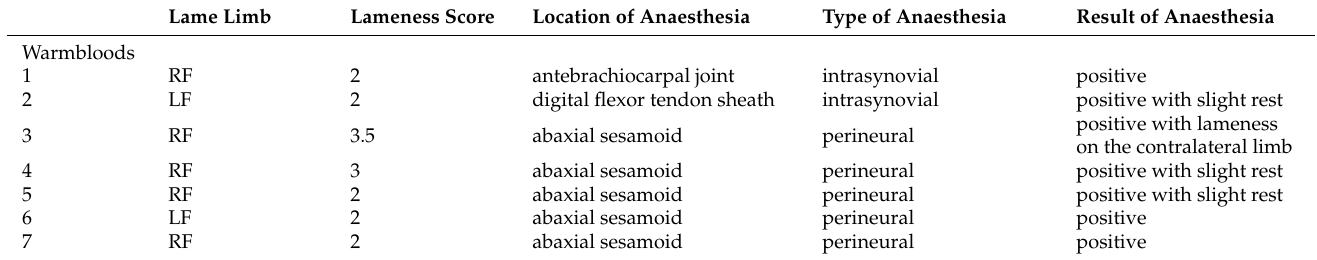
Table 2. Results of lameness examination of horses with forelimb lameness included in the current study involving the breed, the lame forelimb, and the lameness score as well as location, type, and result of